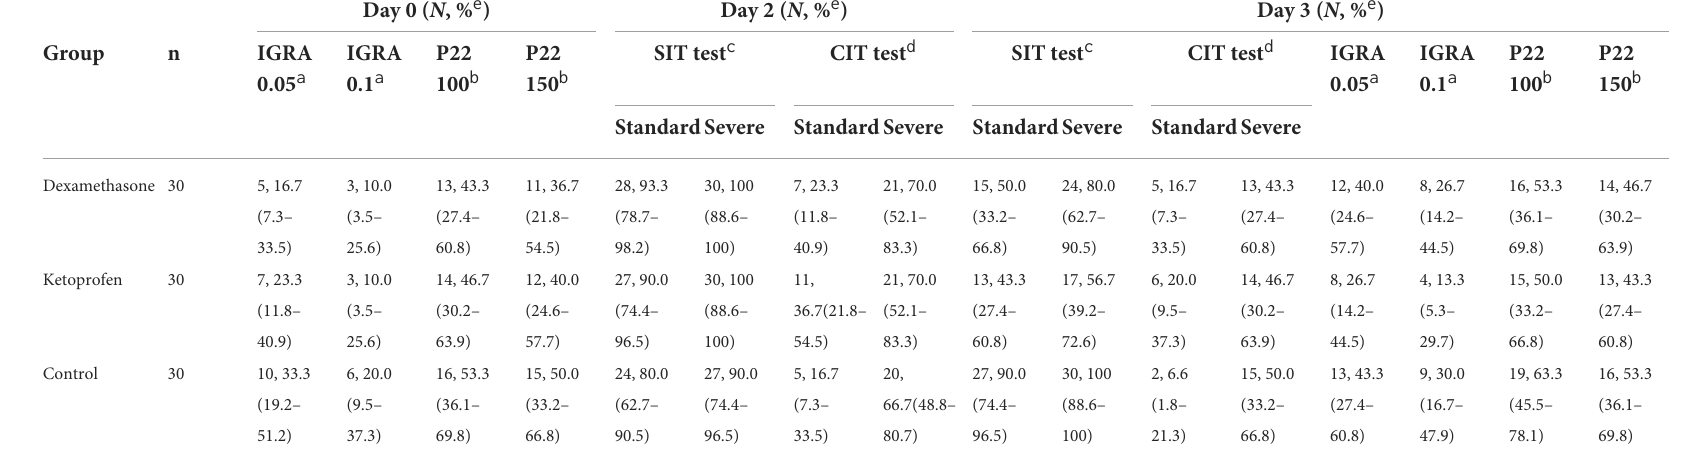
TABLE 1 Number of positive reactors (including percentage and Wilson’s CI 95%) to diagnostic tests in each experimental